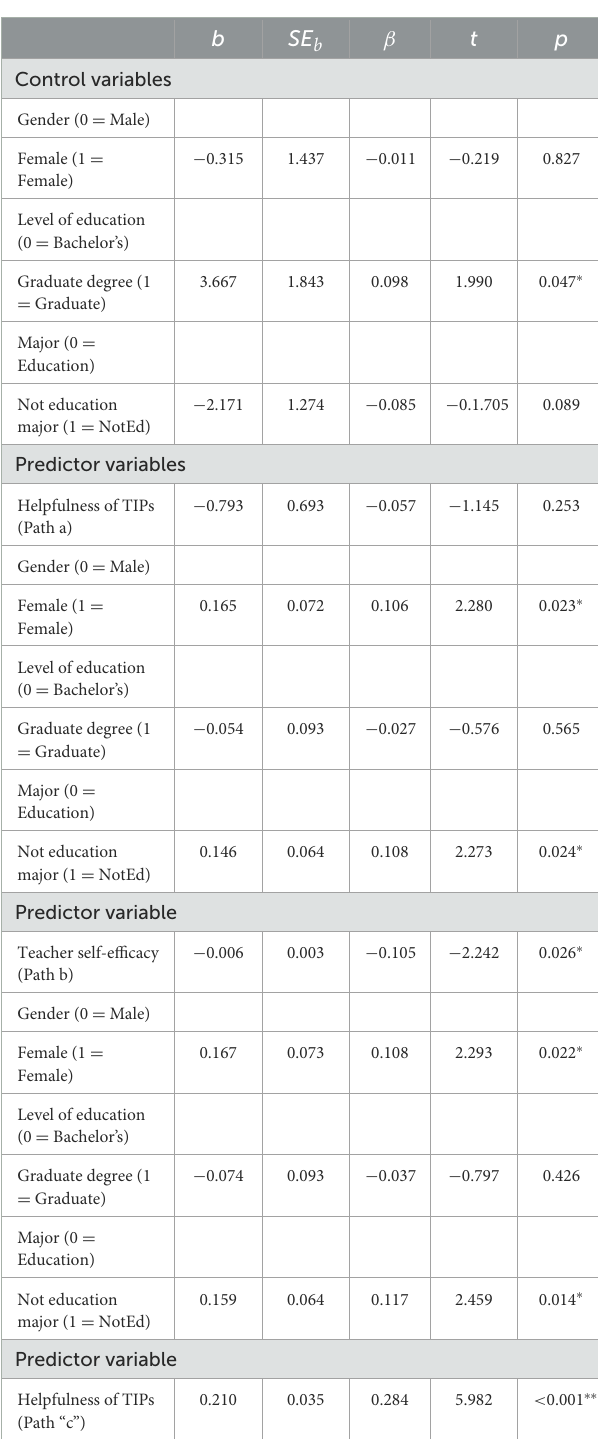
TABLE 2 A path analysis of helpfulness of TIPs, teacher self-efficacy, and anticipated first-year teacher